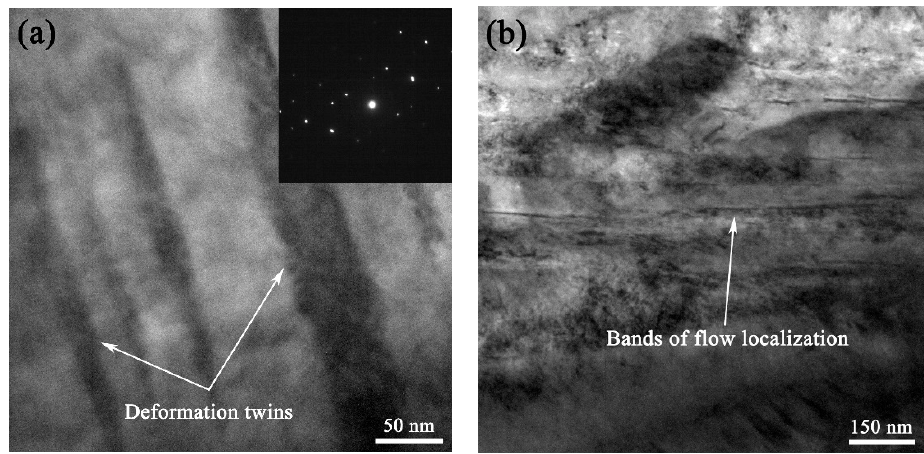
Figure 15. Microstructures of the experimental steel at the hot deformation conditions of: ( a ) 1000 °C/0.01 s − 1 and ( b ) 1100 °C/10 s − 1 .